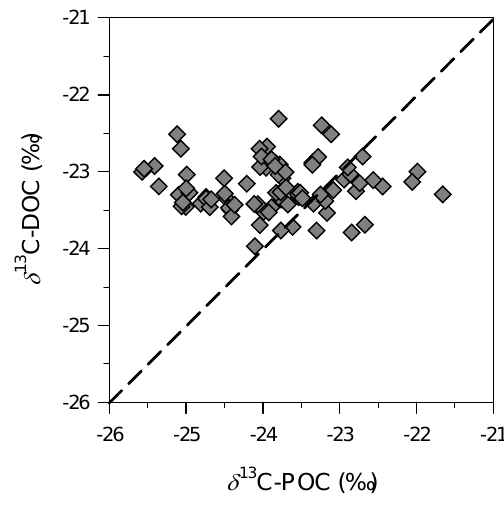
Figure 6. Relationship between the δ 13 C signature of the particulate and dissolved organic carbon pool (POC and DOC, respectively) in the mixed